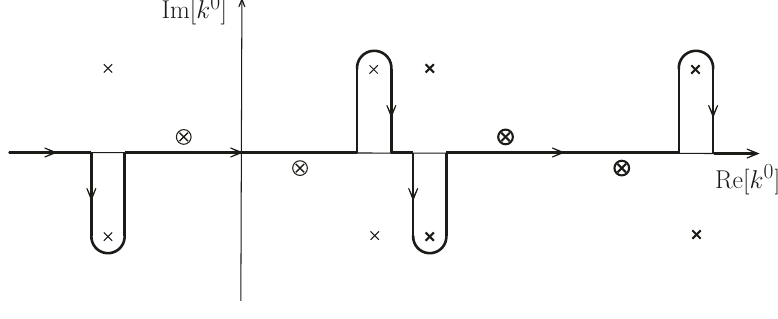
Figure 5 . Integration path of the bubble diagram after the Wick rotation.